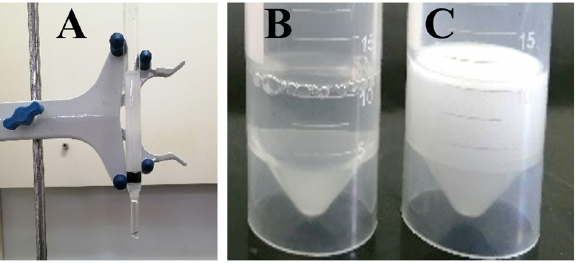
Figure 10. Demulsification using the m-AS/Kaolin@MS as filter medium: the experimental setup ( A ), the obtained filtrate after filtration ( B ), and the original emulsion before filtration ( C ).